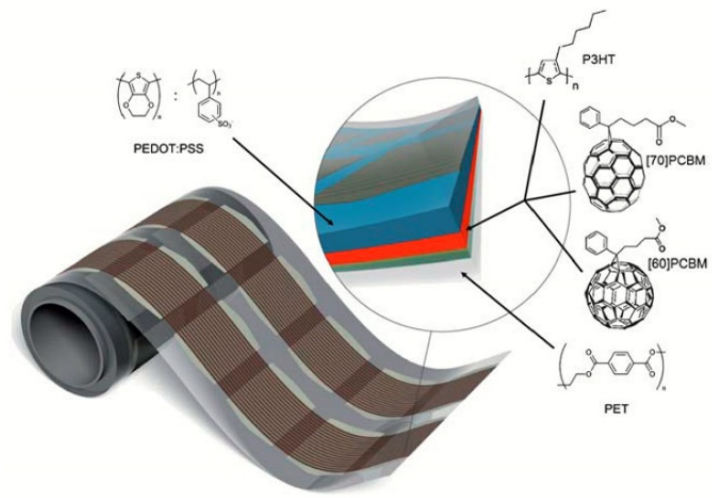
Figure 4. A roll of the printed modules shows how two parallel sets of modules are prepared simultaneously. The zoom-in view shows the layer stack which is PET-ITO-ZnO-P3HT: PCBM-PEDOT: PSS-printed silver. The device stack is encapsulated using roll-to-roll lamination post-production. Reproduced with permission. Ref. [27] Copyright 2010. Royal Society of Chemistry.